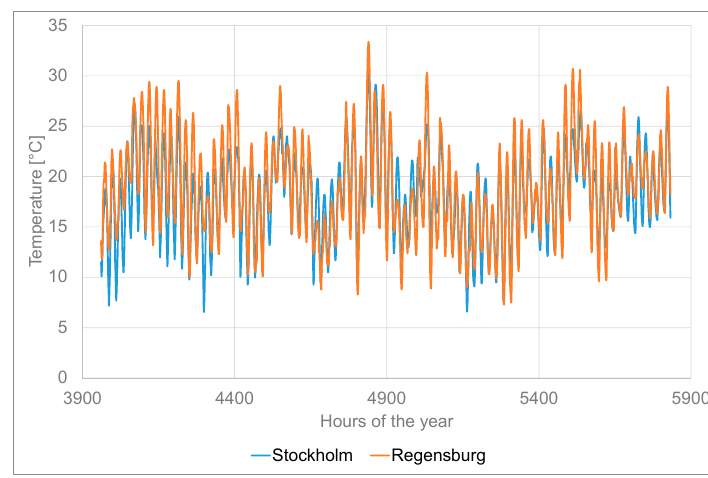
Figure 8. Ambient temperature evolution for the two hot summer months (second half of June, July, and August) for Stockholm and Regensburg.